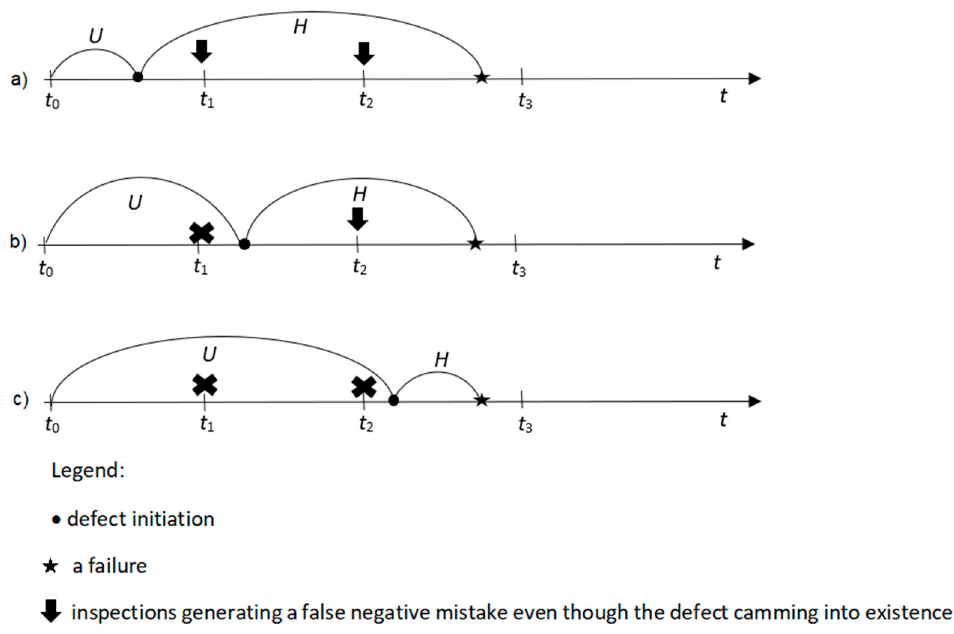
Figure 2. Alternative scenarios of a failure process development resulting in a failure during the third inspection interval.